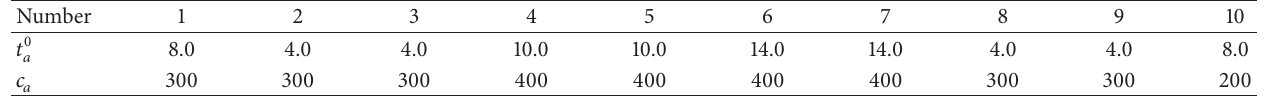
Table 2: Parameters used in link performance functions.